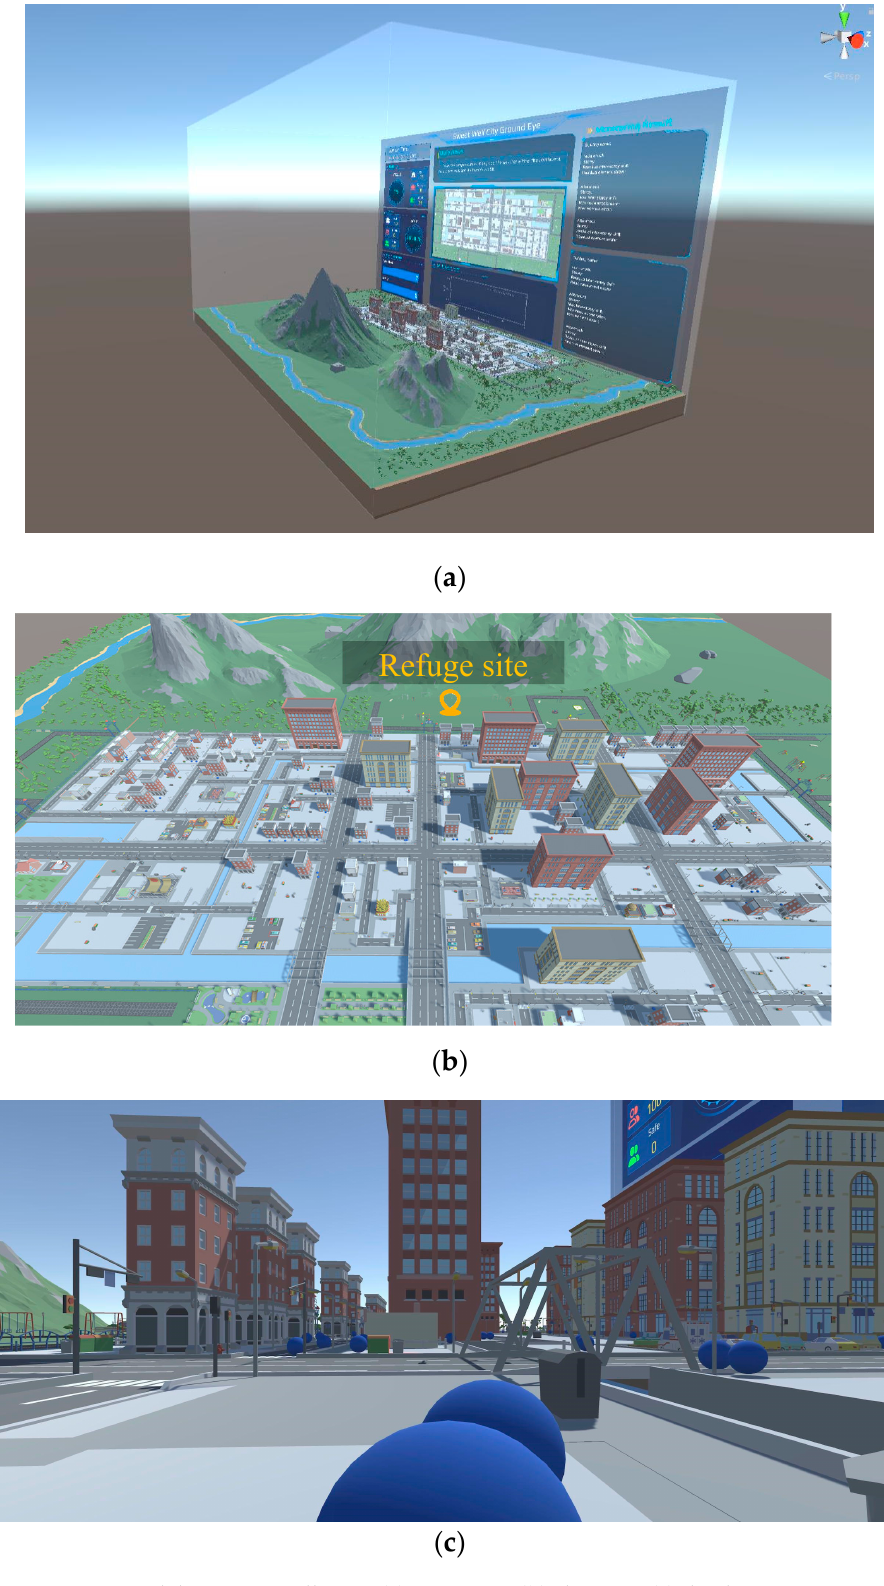
Figure 2. City model—Sweet Well City: ( a ) overview; ( b ) close-up; ( c ) third-person perspective of a citizen.